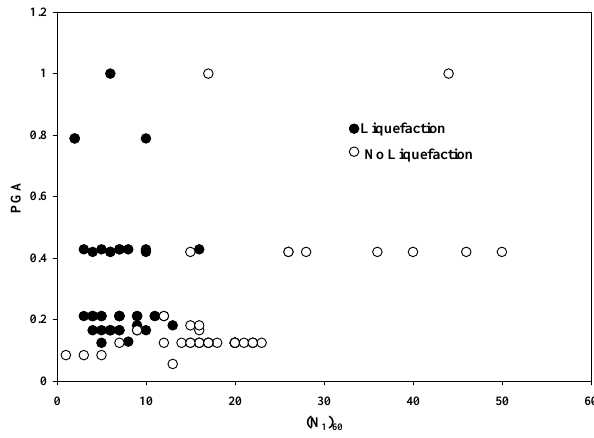
Fig. 8. Plot between PGA and (N 1 ) 60 for MODEL I using training Figure 8. Plot between PGA and (N 1 ) 60 for MODEL I using training dataset for ANN dataset for ANN model.